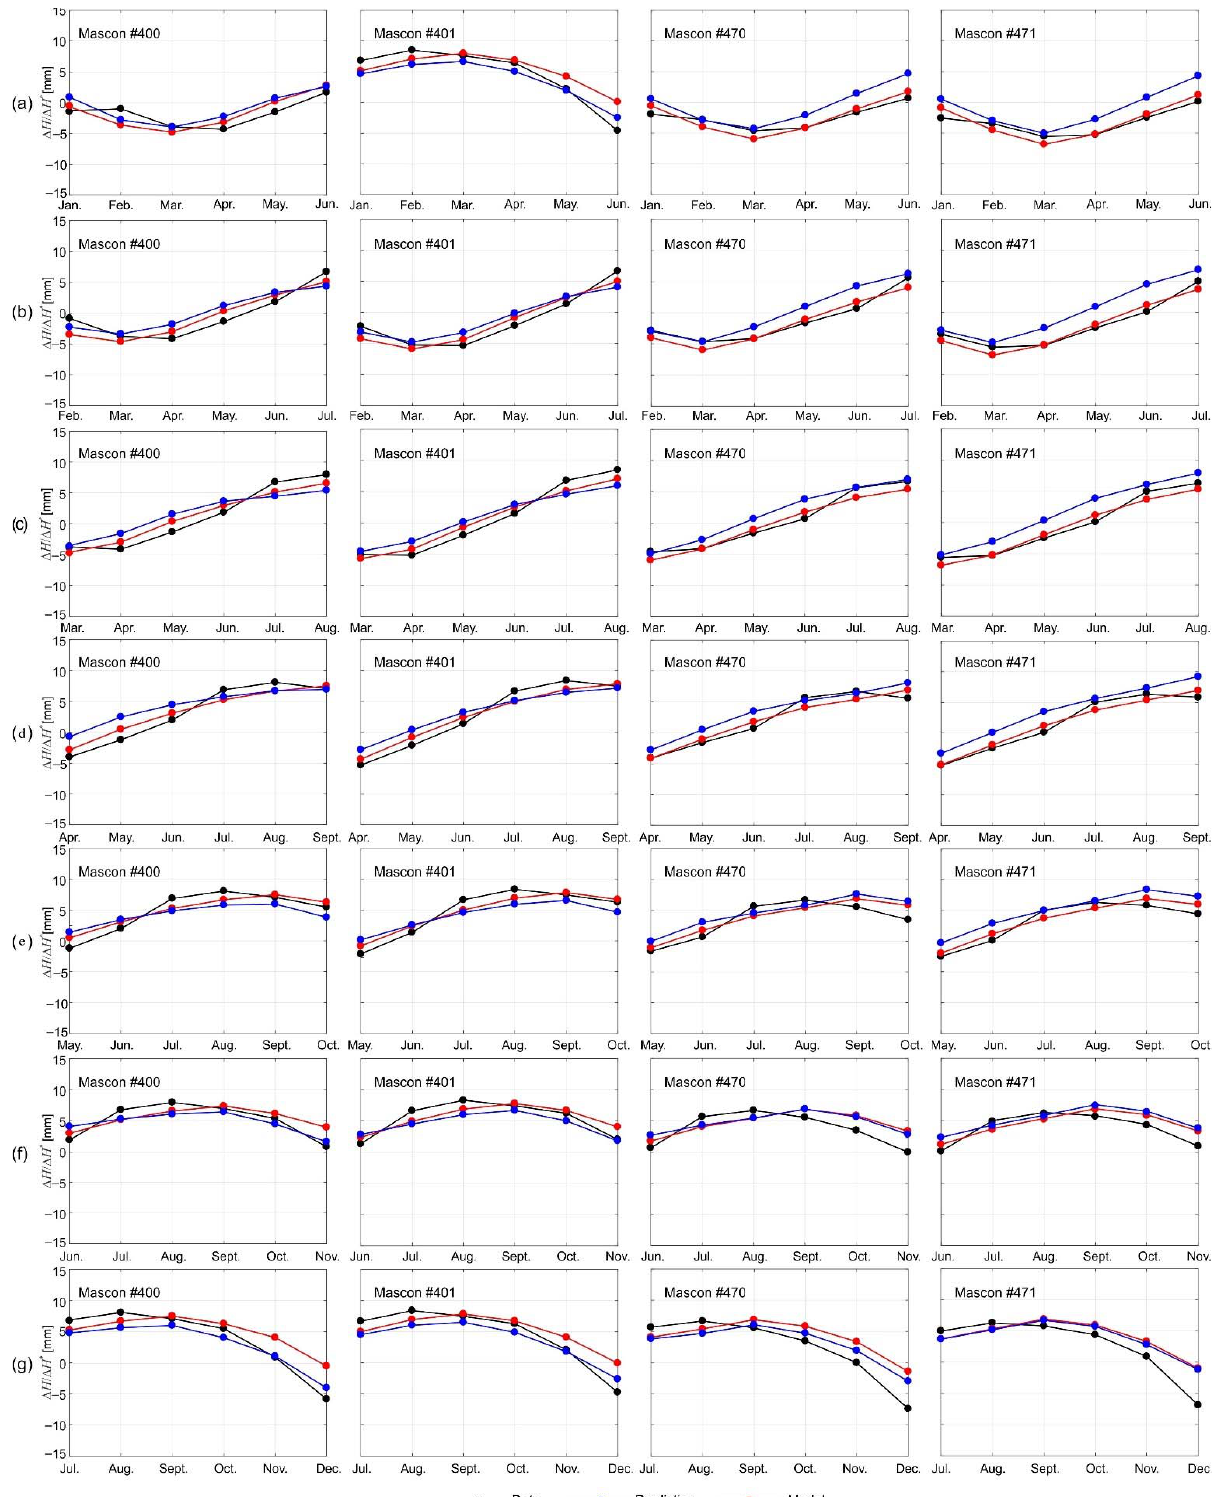
Figure 14. The Δ H c / Δ H * c data shifted by the offset τ , Δ H M / Δ H * M obtained from a model of Δ H / Δ H * developed using the seasonal decomposition method and Δ H P / Δ H * P . The investigated prediction period ( a ) from January to June 2010, ( b ) from February to July 2010, ( c ) from March to August 2010, ( d ) from April to September 2010, ( e ) from May to October 2010, ( f ) from June to November 2010, and ( g ) from July to December 2010.